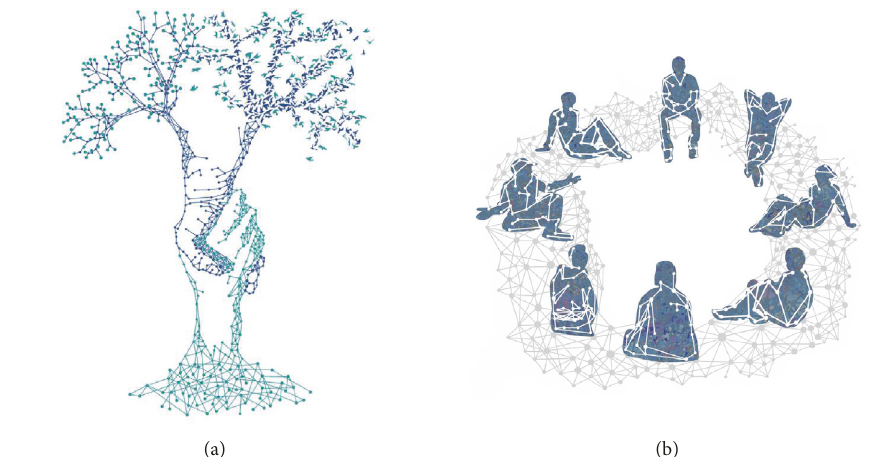
Figure 1: Two of the works produced by J. K. Rofling and taken from [5] with permission of the artist. (a) The Trand. (b) The Guys.